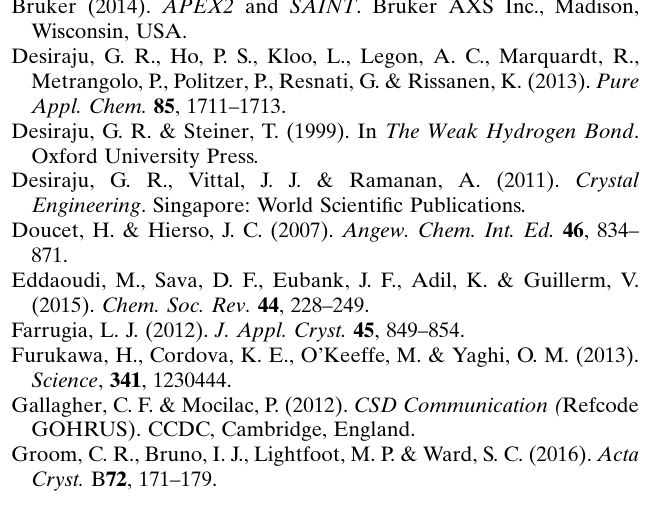
Crystal data Chemical